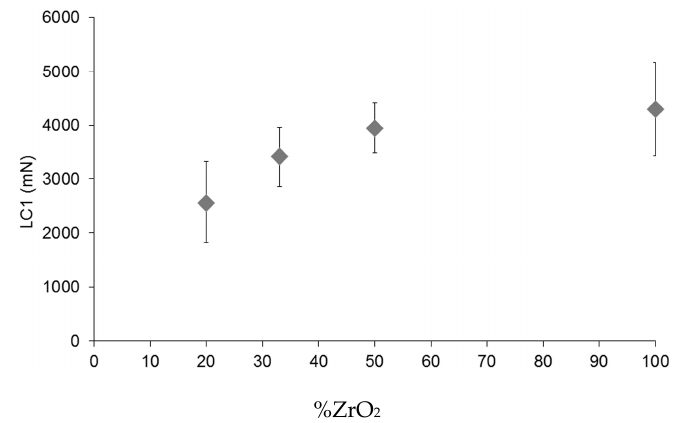
Figure 5 . Results of scratch tests: Critical load (LC1).